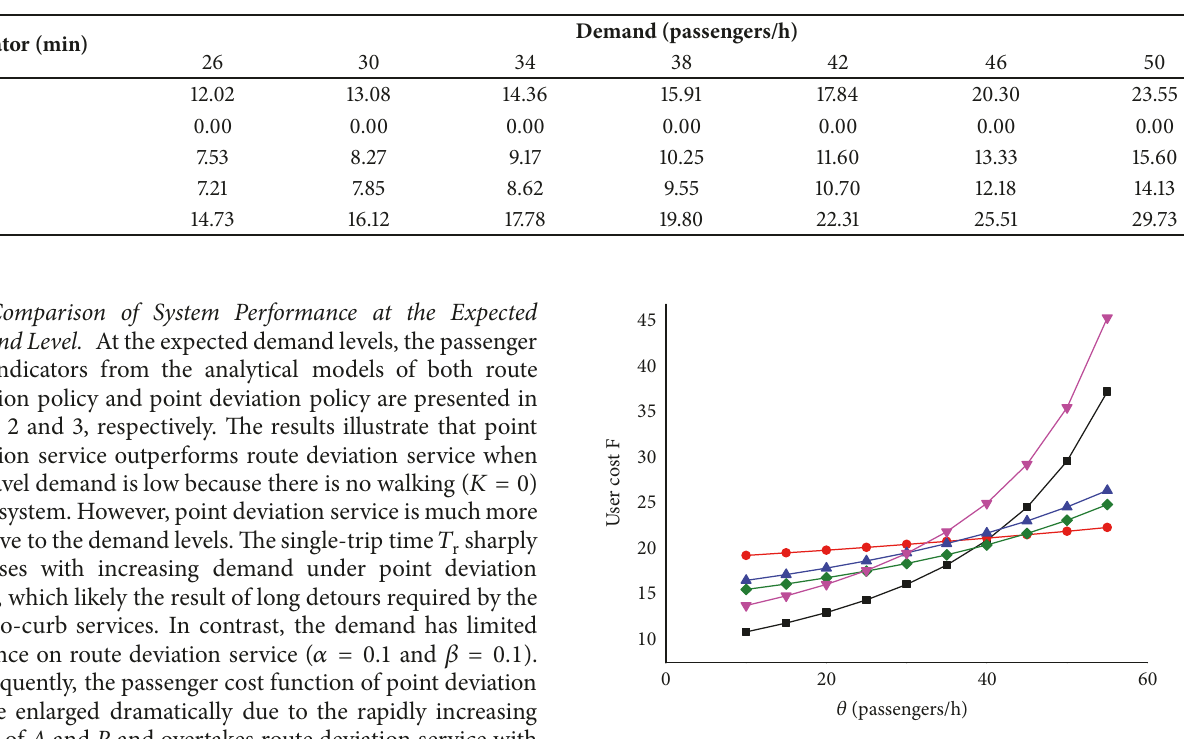
Table 3: Passenger cost indicators in point deviation service.